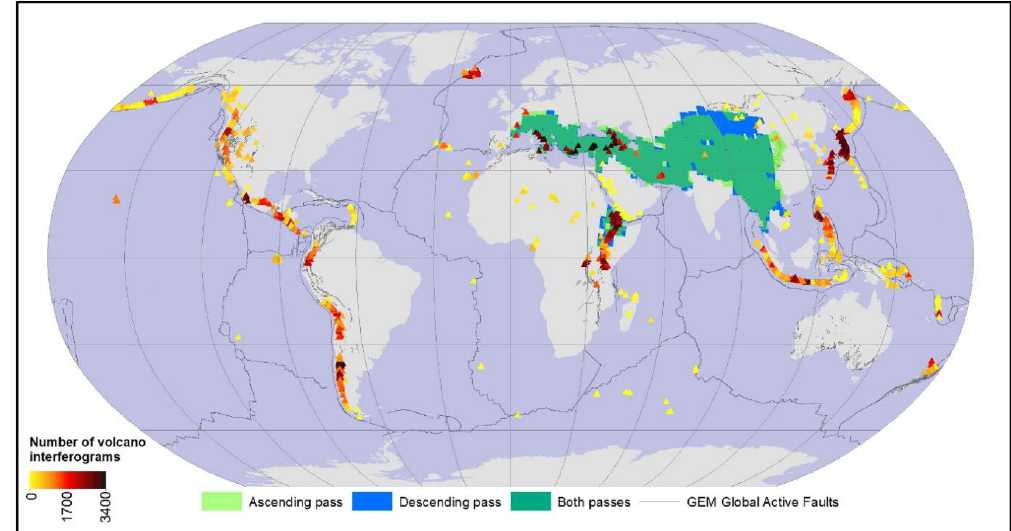
Figure 7. LiCSAR tectonic priority frames (ascending and descending) over the Alpine–Himalayan Belt and the number of interferograms processed by LiCSAR over active volcanoes as of April 2020. Global Active Faults data are from [61] .